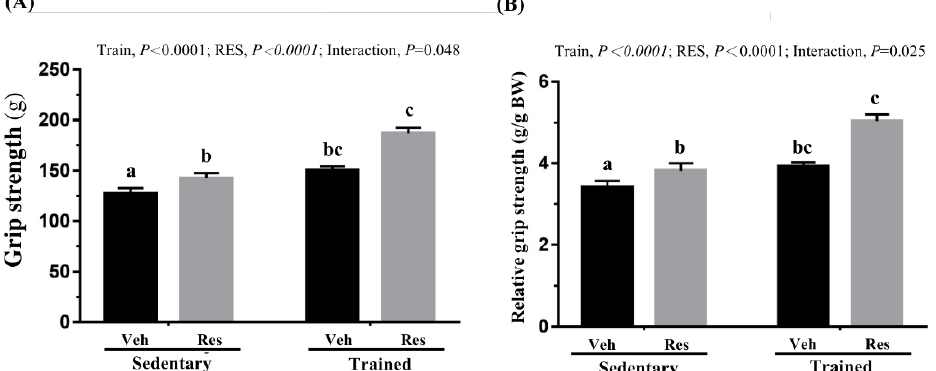
Figure 3. climb training (Trained) and/or resveratrol (RES) supplementation on absolute forelimb grip strength ( A ) and forelimb grip strength (%) relative to bodyweight ( B ). Data are mean ± SEM for n = 10 mice per group. Columns with different superscript letters (a, b, c) are significantly different at p < 0.05. The abbreviations Veh and RES represented the vehicle and resveratrol supplement, respectively.